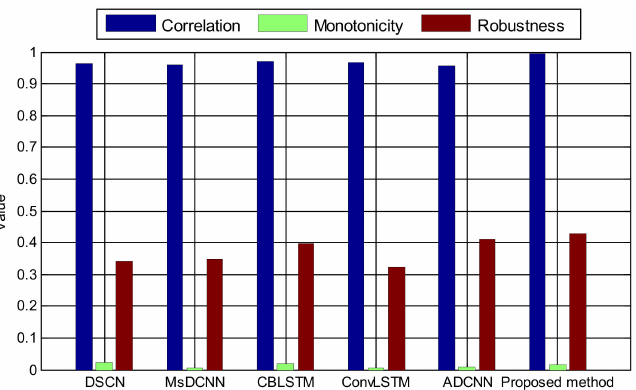
Figure 20. Comprehensive performance comparison of PHM 2012 beaing1_3 RUL prediction